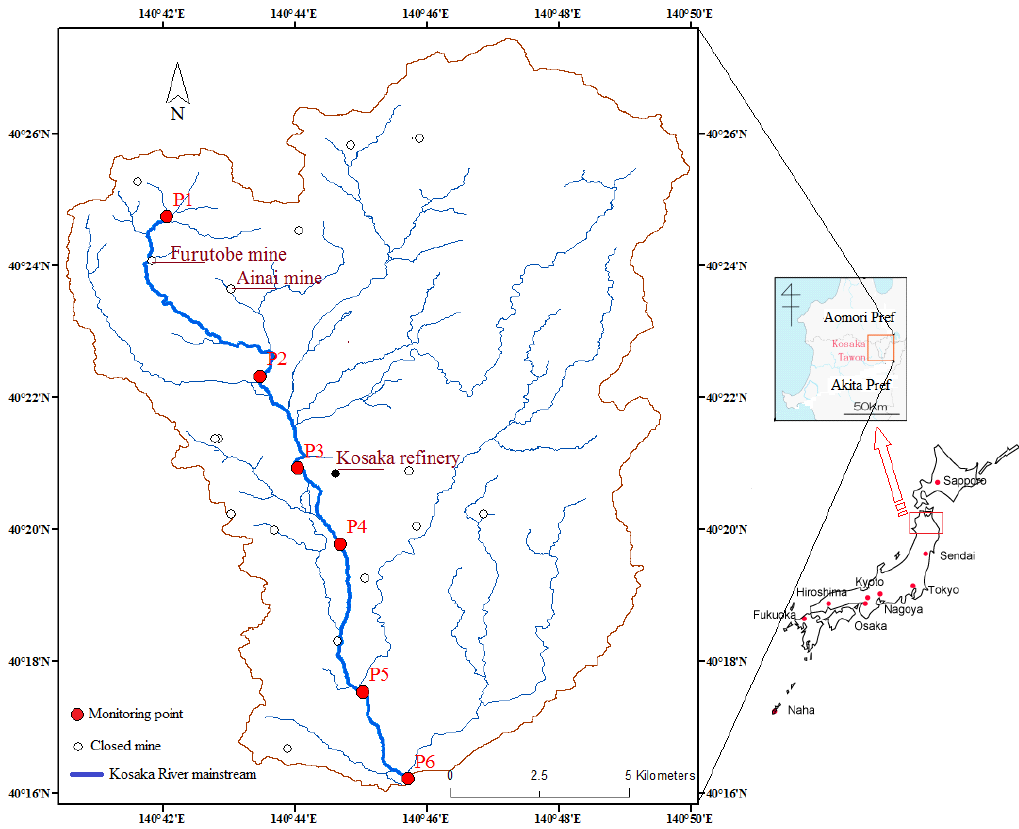
Figure 1. Scope of the study area: the Kosaka watershed in Hokuroku basin, Northeast Japan.